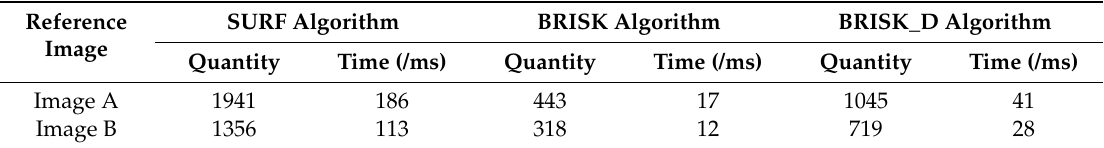
Figure 7. Experimental results of Image A registering with its own. Table 2. The comparison about correct matching number of feature points and time consumption (/ms) by each algorithm.